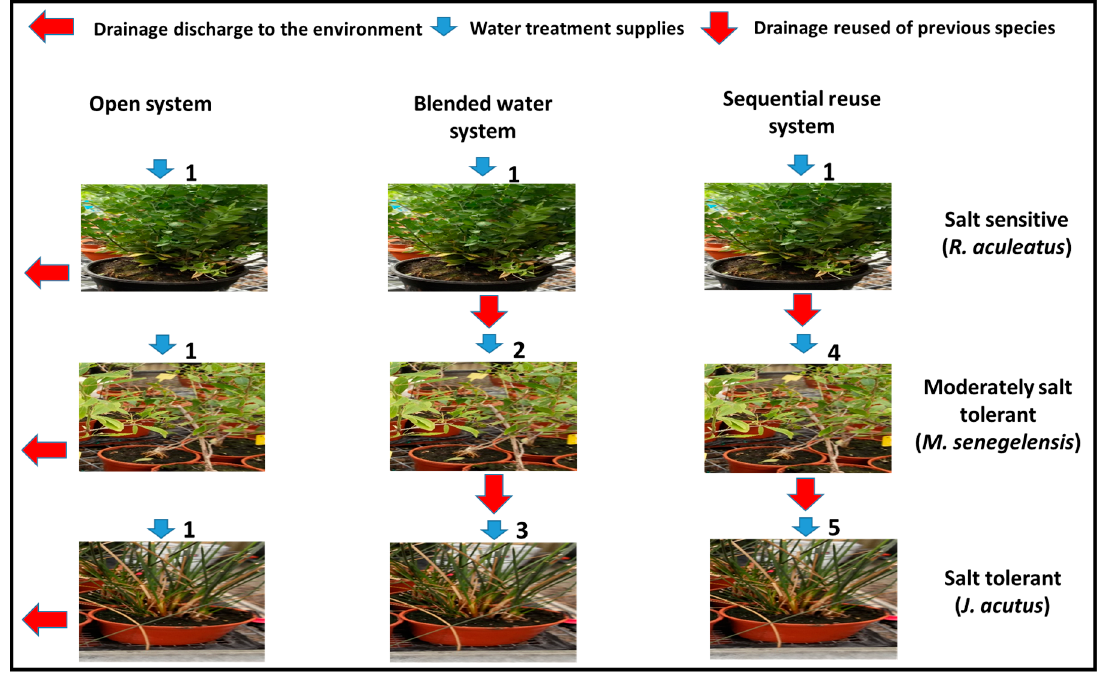
Figure 1. General layout of the different experimental water treatments in order to determine the effect of using drainage water on growth and nutrient removal by three native species. Water number 1: standard nutrient solution; number 2: blend of tap water and drainage from irrigation of R. aculeatus with nutrient solution used to irrigate M. senegalensis ; number 3: drainage from irrigation of M. senegalensis irrigated with water number 2 used to irrigate J. acutus ; number 4: drainage from irrigation of R. aculeatus with nutrient solution used to irrigate M. senegalensis , and number 5: drainage from irrigation of M. senegalensis irrigated with water number 4 used to irrigate J. acutus . Table 1. Chemical composition of the applied water. Electrical conductivity (EC) was expressed in dS m − 1 and nutrient concentration in mmol L − 1 . Water number 1: standard nutrient solution; number 2: blend of tap water and drainage from irrigation of Ra with nutrient solution used to irrigate Ms ; number 3: drainage from irrigation of Ms irrigated with water number 2 used to irrigate Ja ; number 4: drainage from irrigation of Ra with nutrient solution used to irrigate Ms , and number 5: drainage from irrigation of Ms irrigated with water number 4 used to irrigate Ja . Data are the means ± standard deviation of four samples per treatment. For water numbers 2–5, the values are the average values of the different chemical parameters analyzed weekly during the trial.